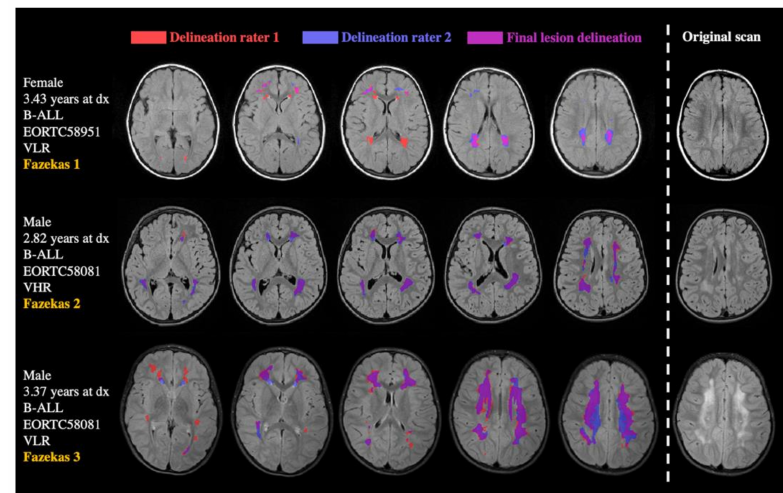
Figure 1. Examples of delineated lesions in three B-ALL cases. Cases are ordered by Fazekas rating (in yellow on the left), with Fazekas 1 showing the lowest lesion load in the upper case. Separate delineations of the two raters are presented in red and blue. The overlapping area, which was defined as final lesion mask, is depicted in